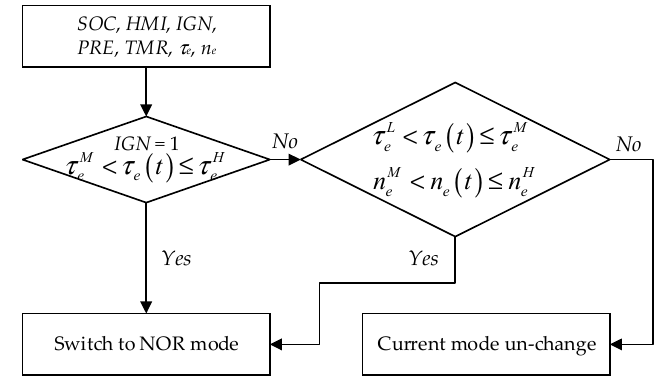
Figure 8. Logics for NOR mode decision.